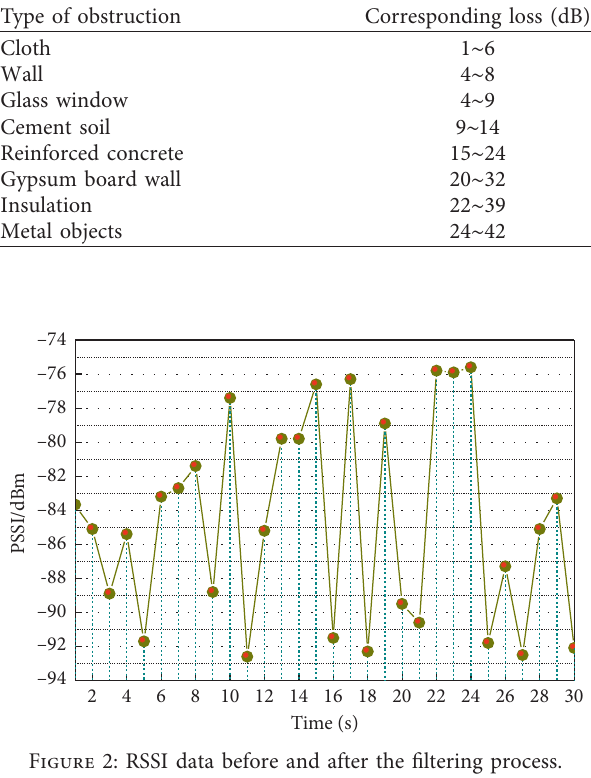
Figure 2: RSSI data before and after the filtering